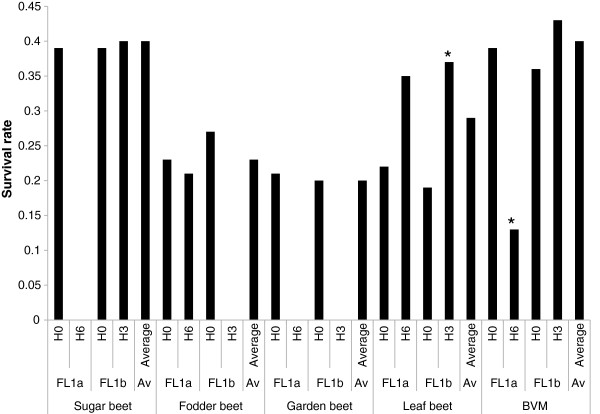
BvFL1 haplotype effect on survival rate after winter. Graphic representation of the effect of BvFL1 haplotypes of the amplicons FL1a and FL1b on survival rate after winter in five B. vulgaris forms. * marks non-reference haplotypes with a significantly different survival rate from the reference haplotypes FL1a_H0 or FL1b_H0 (alpha = 0.05); BVM = B. vulgaris ssp. maritima.